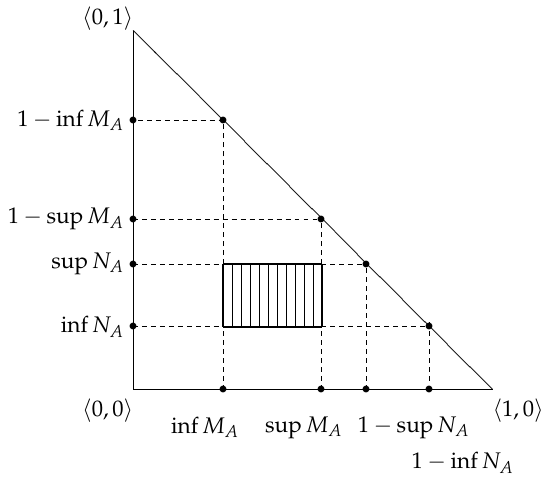
Figure 2. The second geometrical interpretation of an interval-valued intuitionistic fuzzy set